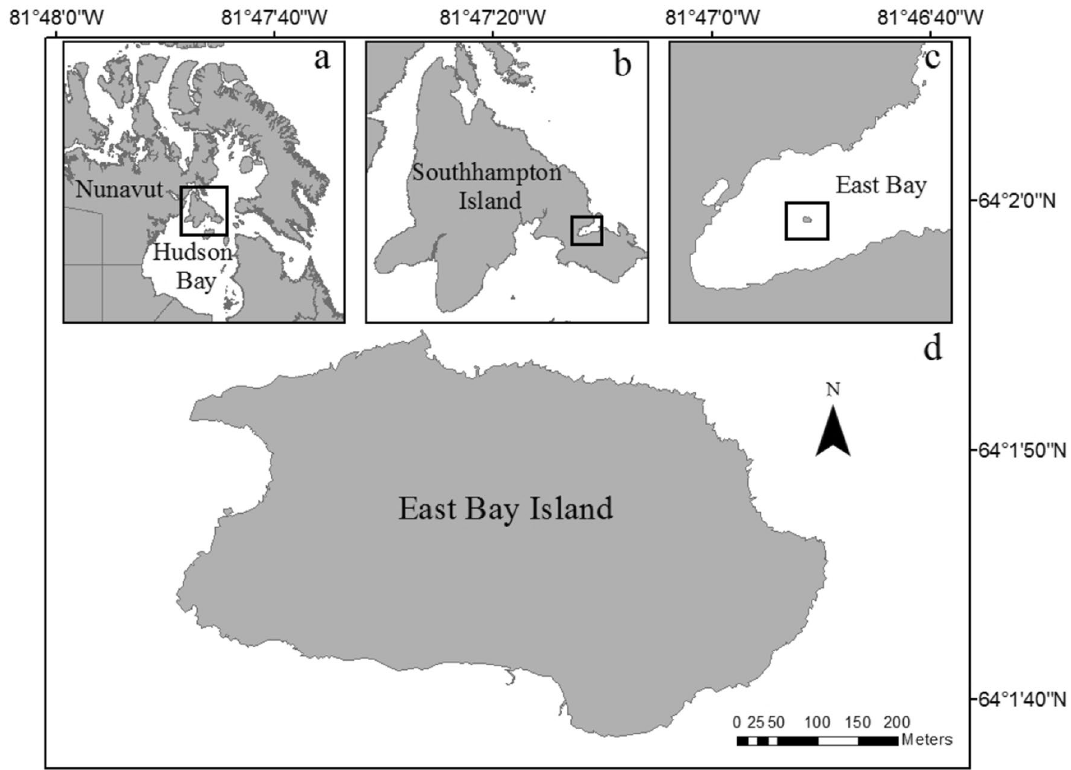
Figure 3. Map of study area, ( a ) Nunavut, Canada, ( b ) Southampton Island, Nunavut, Canada, ( c ) East Bay, Nunavut, Canada and ( d ) East Bay Island, Nunavut, Canada. Canadian Provinces and Territories map layers provided by ESRI online, accessed May 30, 2018. Map layer of East Bay Island created using ArcMap v10.6.1 (Esri, Redlands, CA,